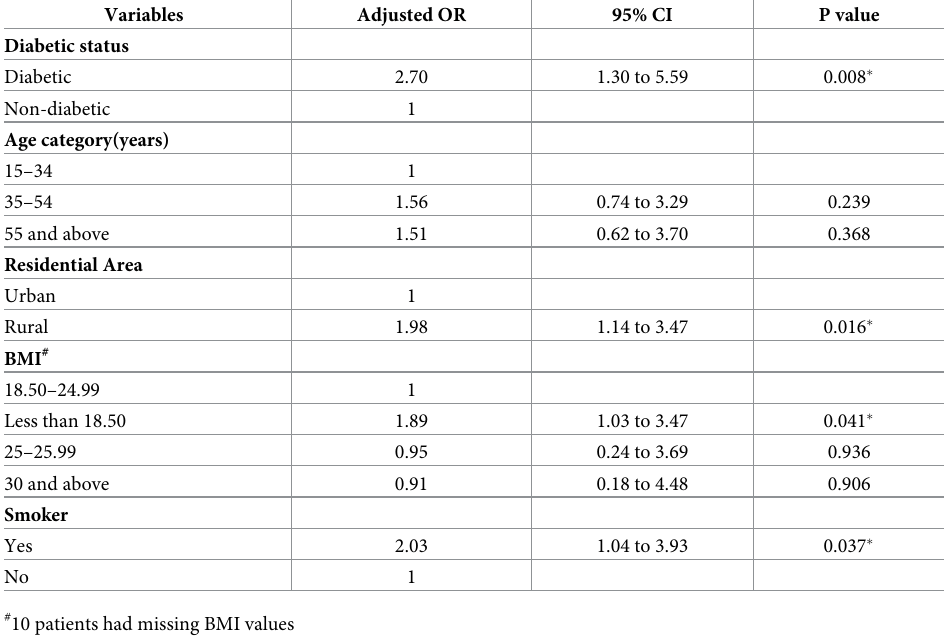
Table 3. Multivariate analysis for predictors of favourable and unfavourable treatment outcome among 493 ¶ pul- monary tuberculosis patients. Variables Adjusted OR 95% CI P